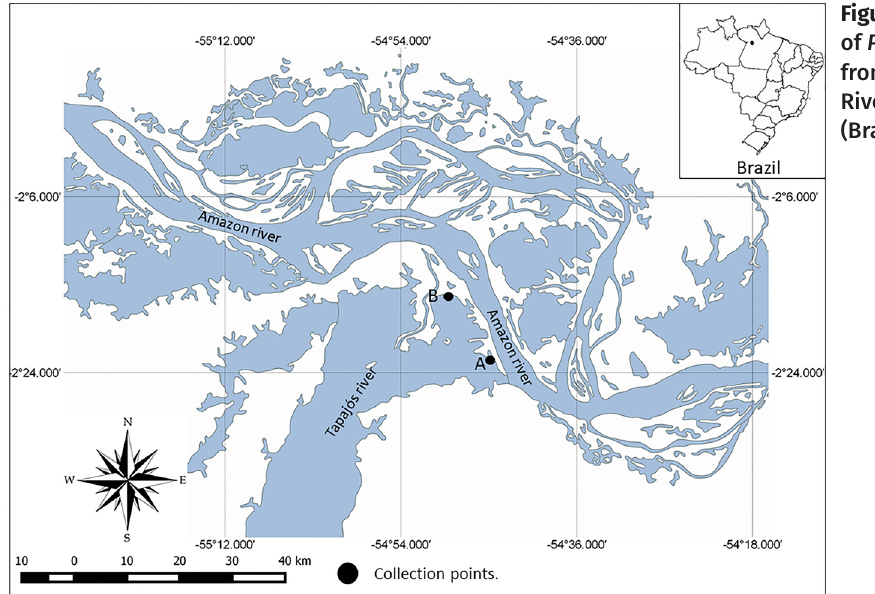
Figure 2. Collection locations of Pterygoplichthys pardalis from the mouth of the Tapajós River, in eastern Amazon